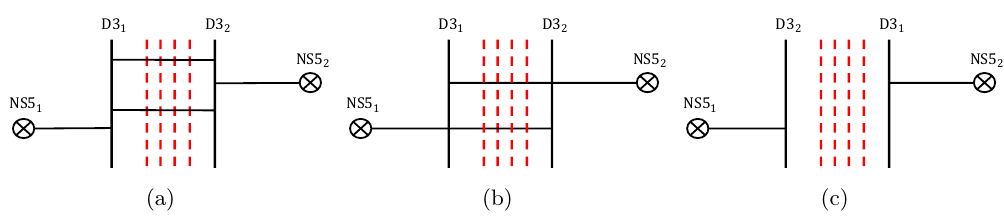
Figure 3 . (a) A brane con(cid:12)guration for B = (cid:0) e 1 + e 2 with (cid:12)nite D1-branes representing smooth monopoles. (b) The D1-branes reconnect to give charge v = e 1 (cid:0) e 2 . (c) After moving around in the ( x 4 ; x 5 )-space the two D3-branes get permuted; the resulting magnetic charge is again (cid:0) e 1 + e 2 with non-decreasing